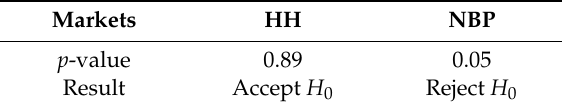
Table 4. Goodness of fit test results.